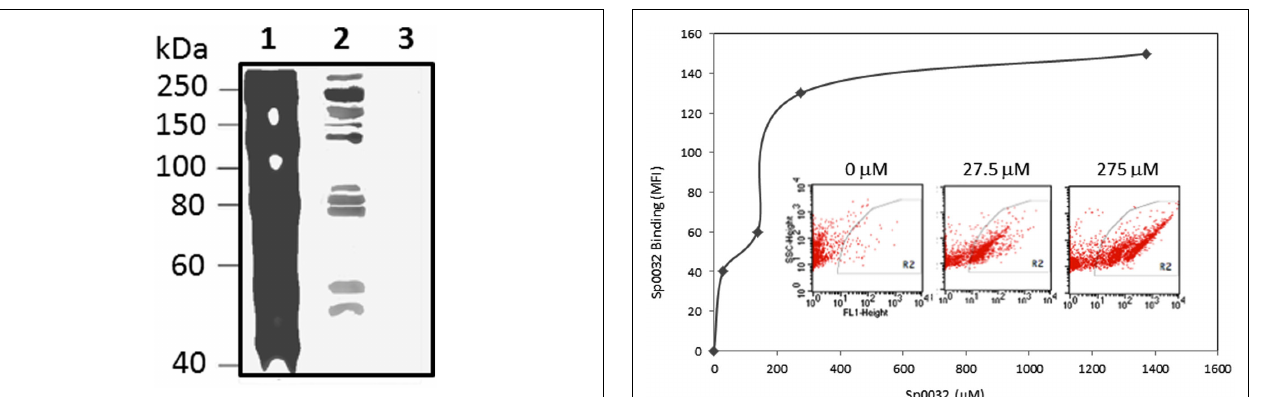
FIGURE 14 |A recombinant Sp185/333 protein (rSp0032) binds Vibrio diazotrophicus ( Vd ). Biotinylated rSp0032 incubated with 10 9 Vd cells and post-labeled with Neutravidin–FITC shows increased binding with increased protein concentration within the gate area (R2). Binding plateaus at about 400mM of rSp0032 indicating the saturation point. MFI, mean fluorescence intensity. Results from flow cytometry (inserted images) show fluorescence ( X -axis; fluorescent events measuring FITC) associated with bacterial cells ( Y -axis; side scatter or cell counts) for increasing concentrations of rSp0032. Unpublished figure provided by Catherine